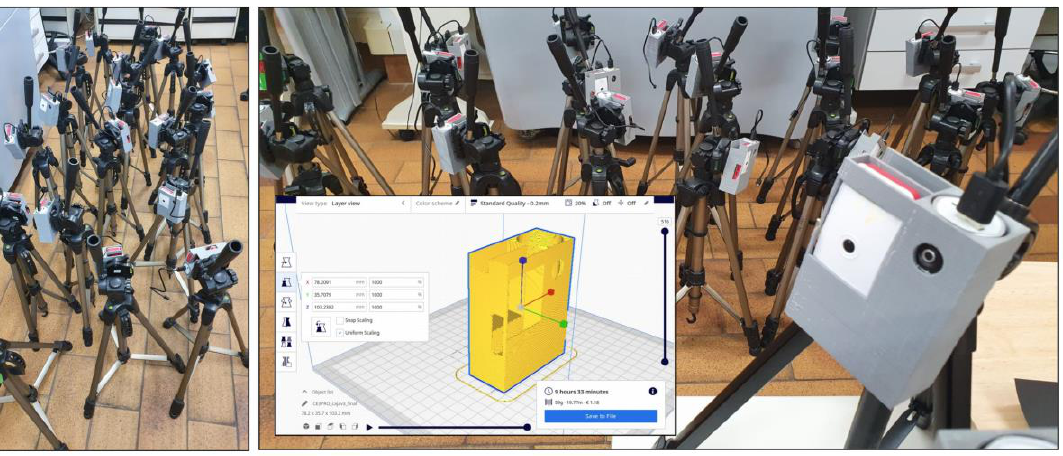
Figure 4. Prototype of the designed sensor.